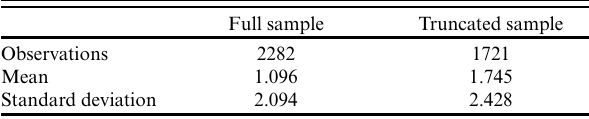
Table 5 . Statistics for the full sample and truncated